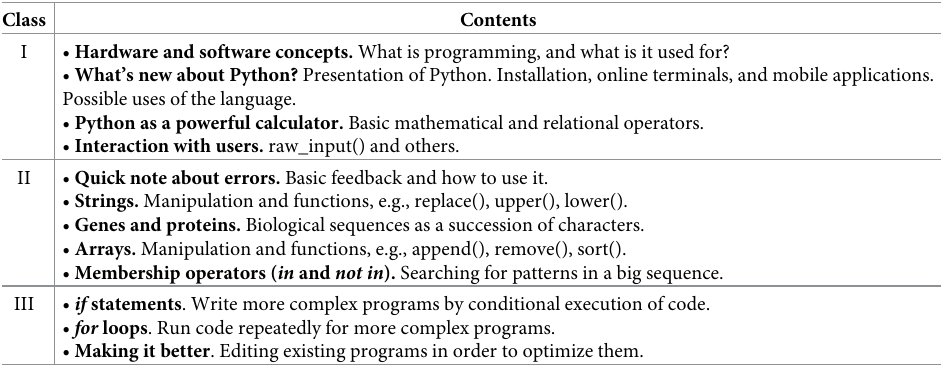
Table 1. Course topics and